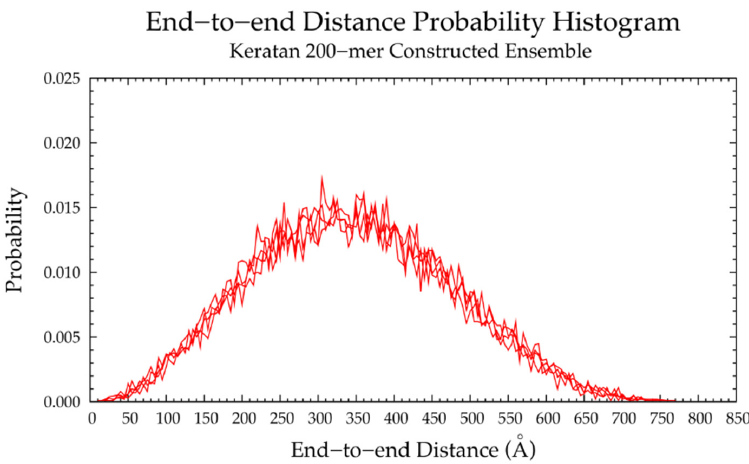
Figure 18. End-to-end distance probability distribution of constructed ensemble of nonsulfated keratan 200-mer; most probable end-to-end distance across all four sets is 305 Å; probabilities were calculated for end-to-end distances sorted into 5 Å bins; the ensemble contains four sets of 10,000 conformations.